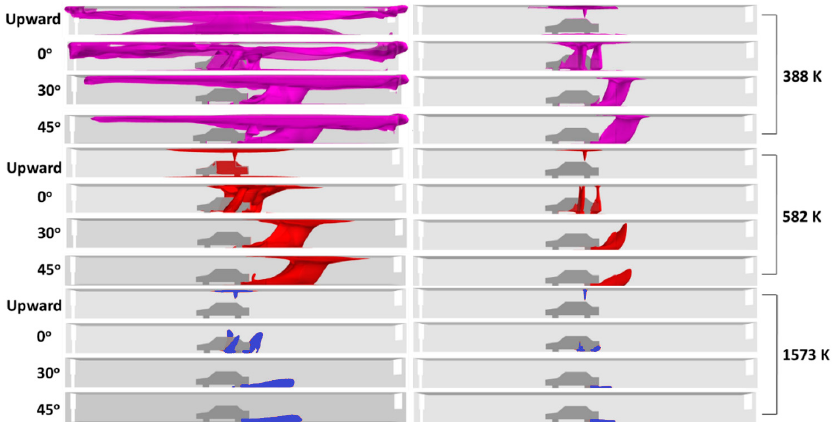
Figure 19. Side view iso-surfaces showing pain (388 K) and fatality (582 K) temperature limits and visible flame temperature (1573 K) for release time 20 s. Left: TPRD = 2 mm, “Upward”—case 3; downward at 0°—case 4, 30°—case 5, 45°—case 6). Right: TPRD = 0.5 mm, “Upward”—case 8; downward at 0°—case 9, 30°case 10, 45°—case 11).